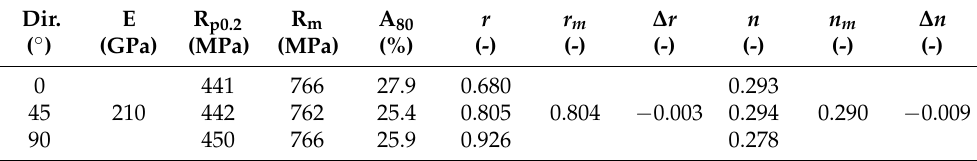
Table 2. The mechanical properties and formability parameters of the RAK 40/70 Z100MBO. Dir.